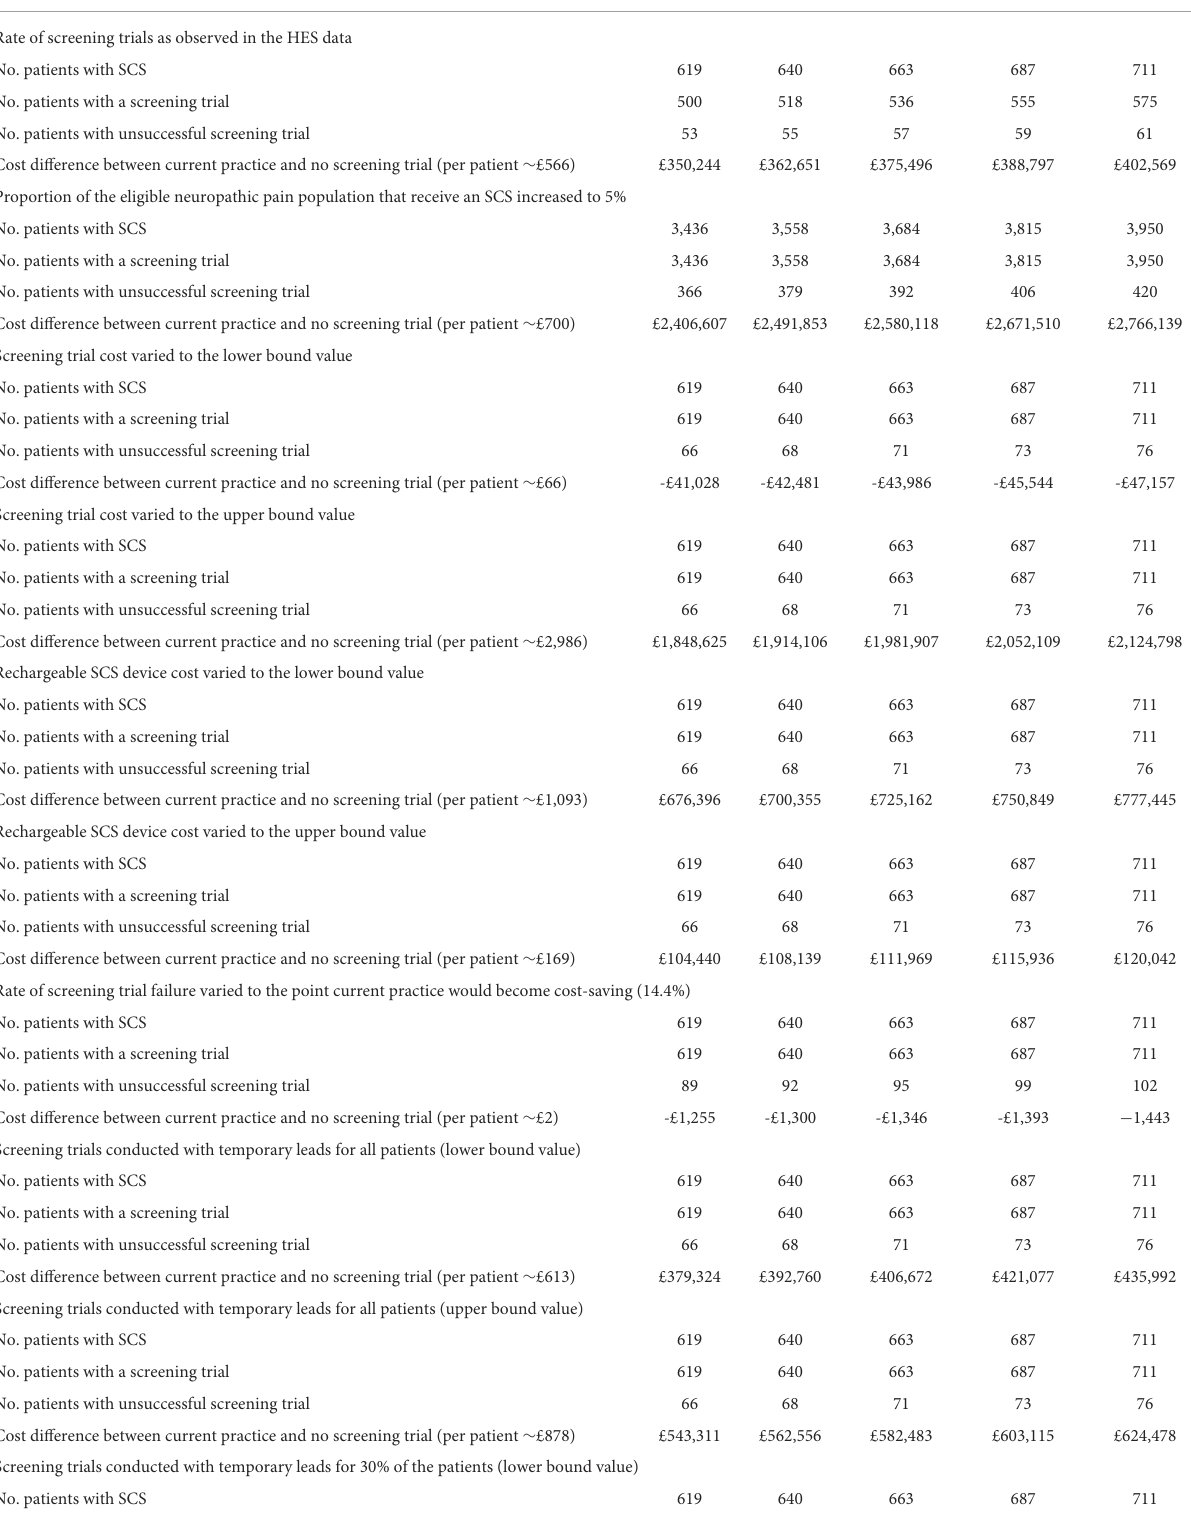
TABLE 4 Sensitivity analysis